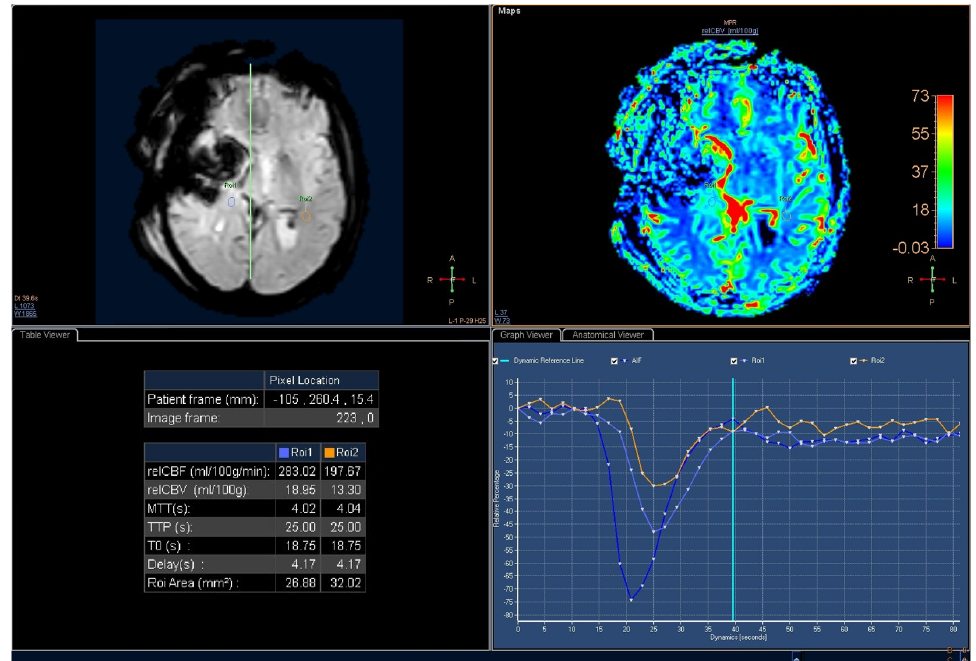
Figure 3. Perfusion Weighted Imaging of the same patient as in Figure 1. An increase in perfusion is visible ain the nodule (ROI 1) compared with the contralateral white matter (ROI 2). The rCBV ratio is greater than 1.4. ROI: Region Of Interest; AIF: Arterial Input Function.